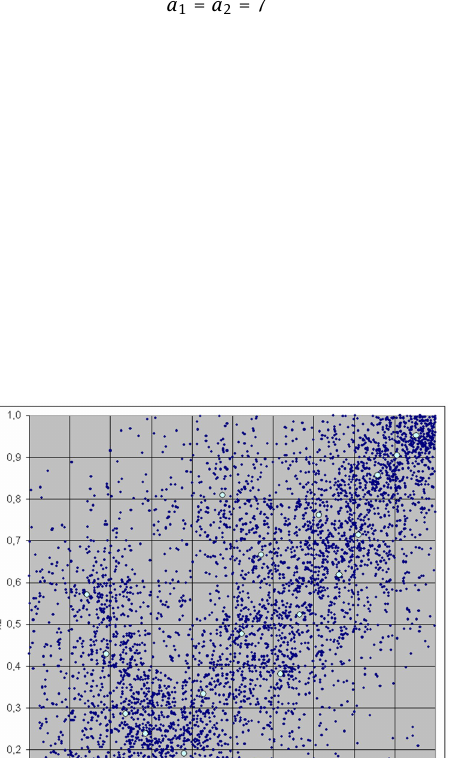
Figure 24: Gamma copula with LF copula driver, Figure 25: Gamma copula with LF copula driver,